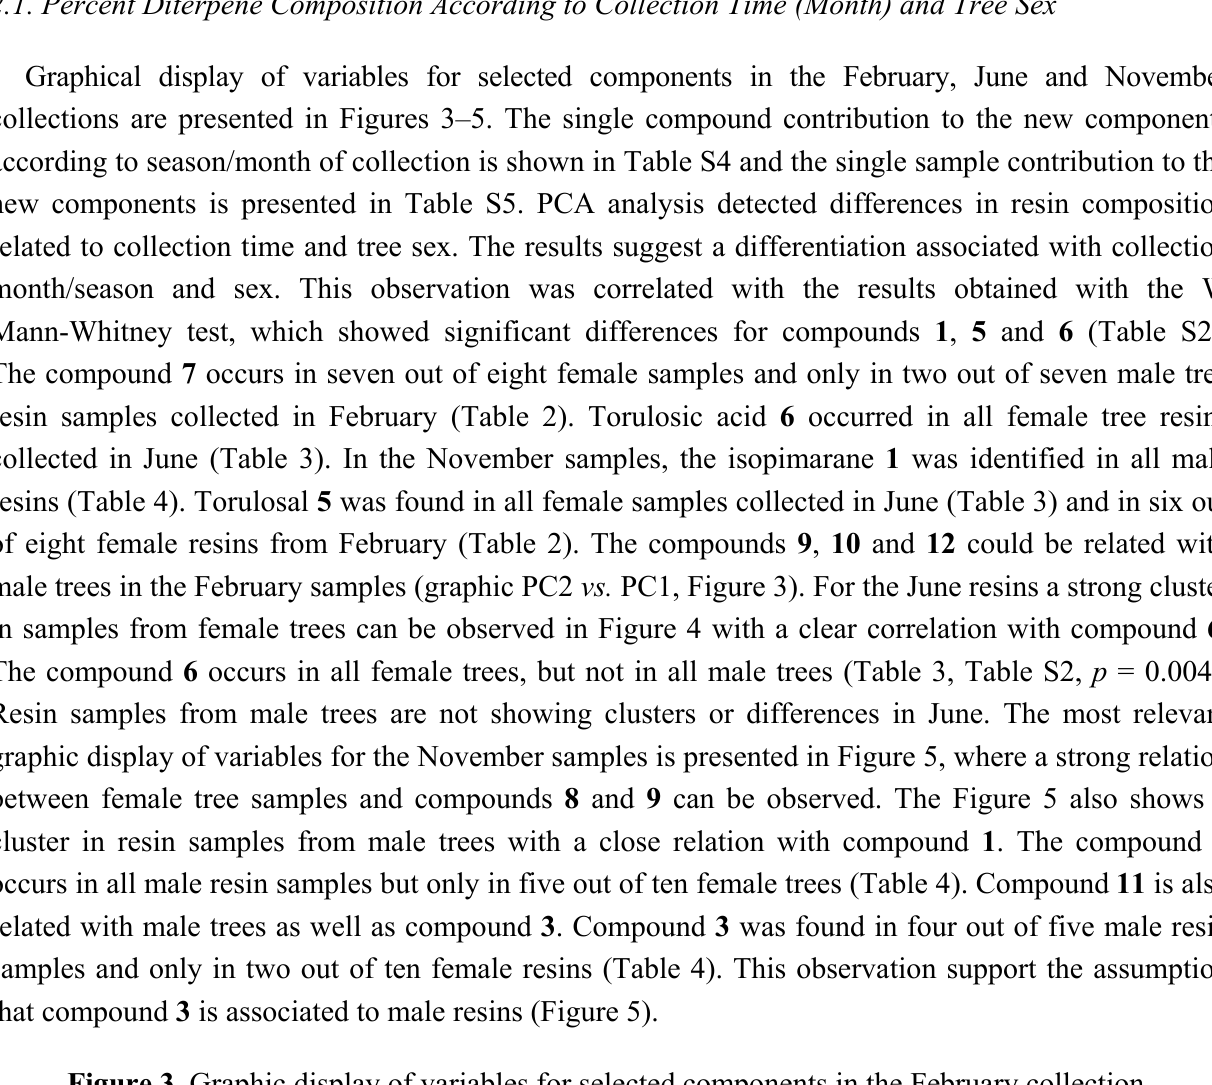
Figure 3. Graphic display of variables for selected components in the February